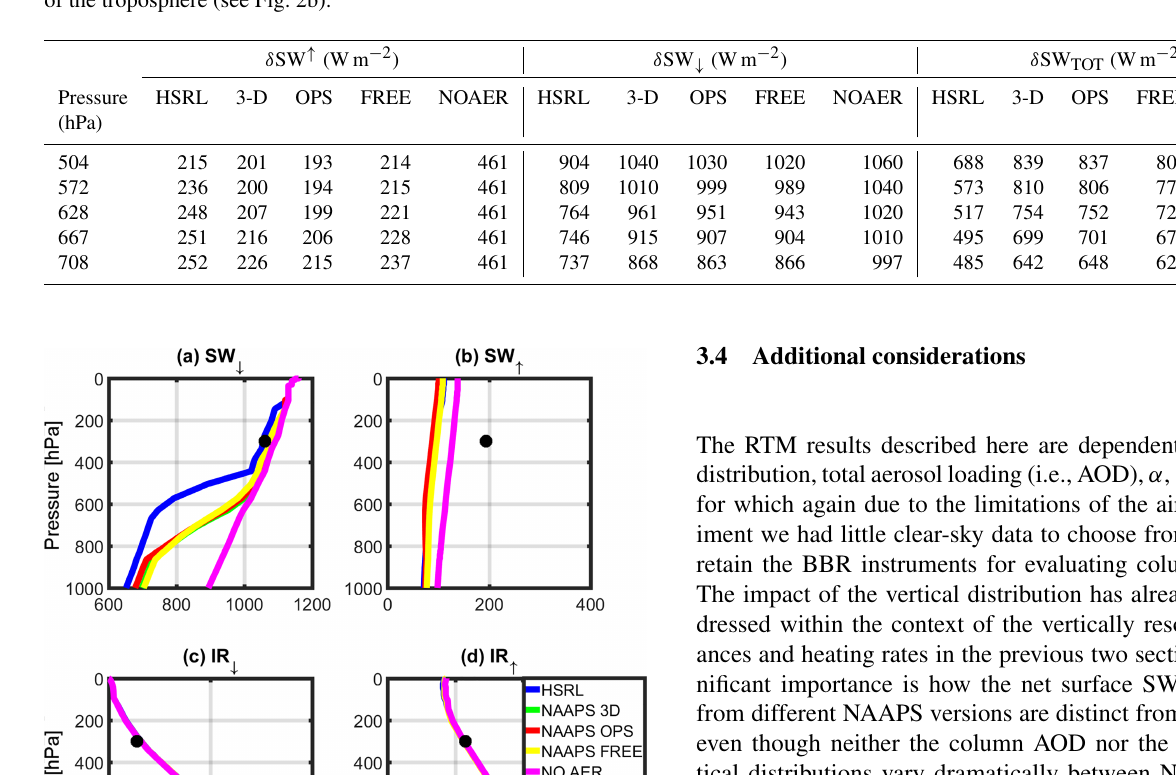
Table 3. Instantaneous SW radiative forcing (in Wm − 2 ) calculated values, corresponding to HSRL smoke/urban aerosol layers in the middle of the troposphere (see Fig. 2b).